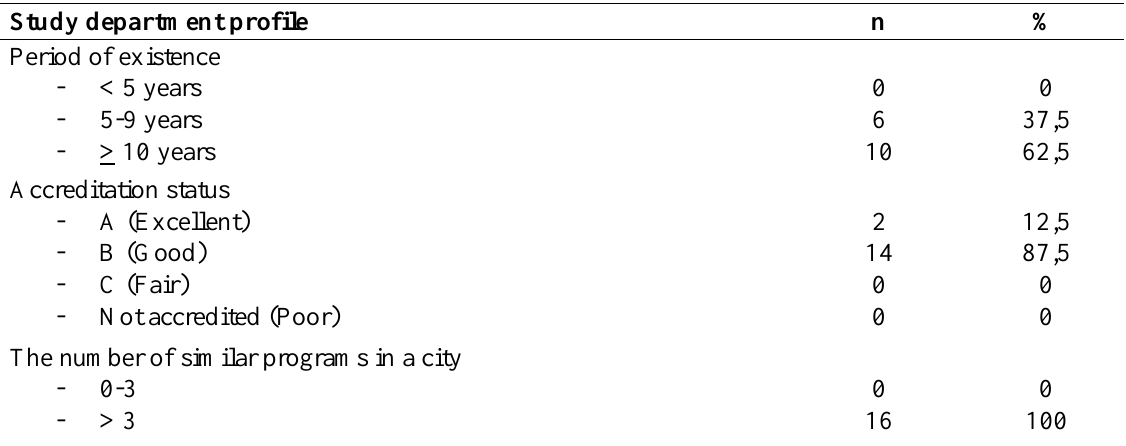
Table 1. Profile of nursing schools under Muhammadiyah universities in 2016 Study department profile